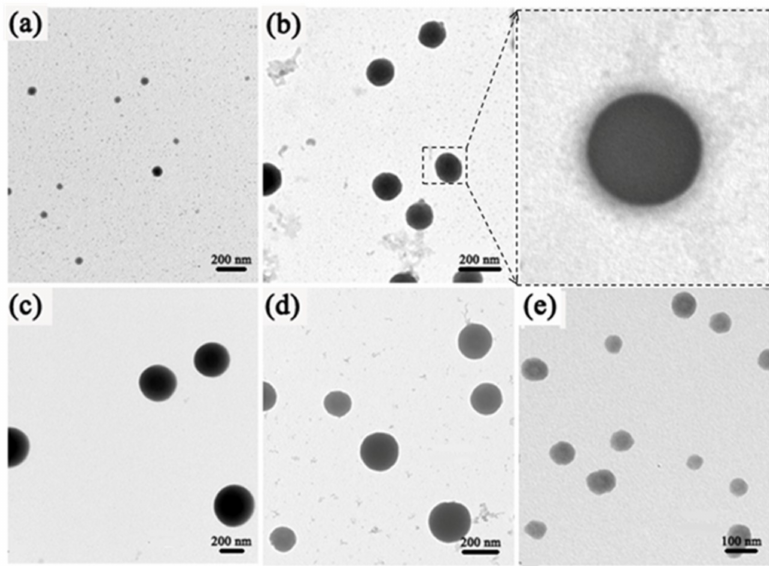
Figure 5. TEM images of samples with Eu 3+ /Tb 3+ molar ratios of ( a ) Eu 3+ /Tb 3+ = 3:1, ( b ) Eu 3+ /Tb 3+ = 2:1 and its magnified image, ( c ) Eu 3+ /Tb 3+ = 1:1, ( d ) Eu 3+ /Tb 3+ = 1:2, ( e ) Eu 3+ /Tb 3+ = 1:3.